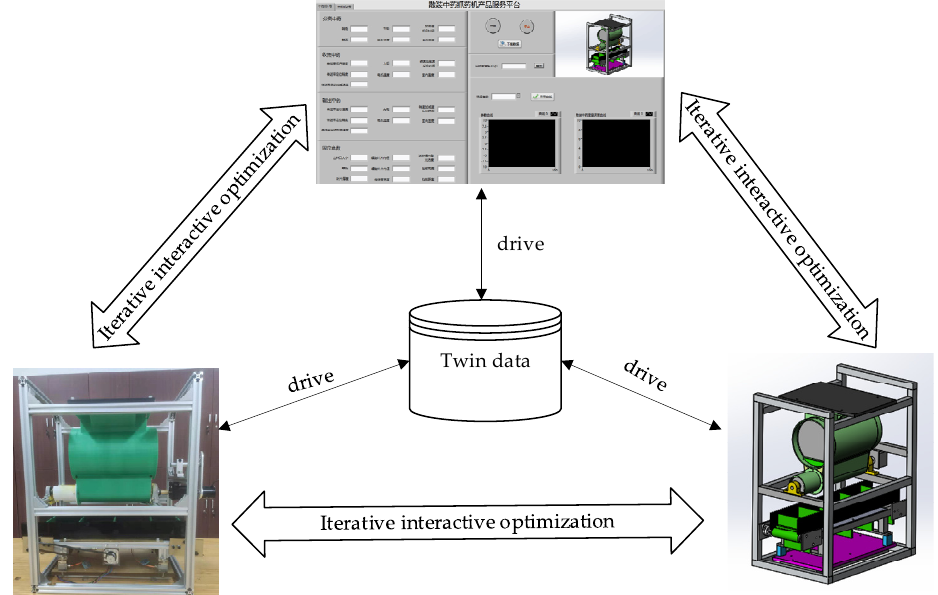
Figure 11. The digital twin model of the powder granular bulk TCM dispensing device. Step 1: Firstly, several new design schemes are obtained from the designer.